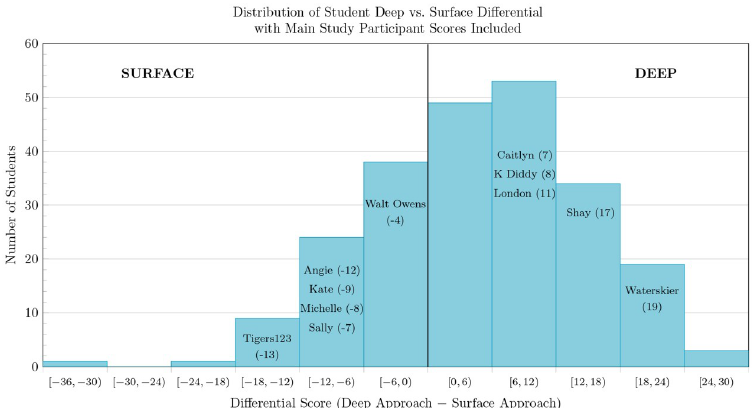
Fig 1. Distribution of differential scores for students in our sample ( n = 231), with participant scores highlighted ( n = 11).